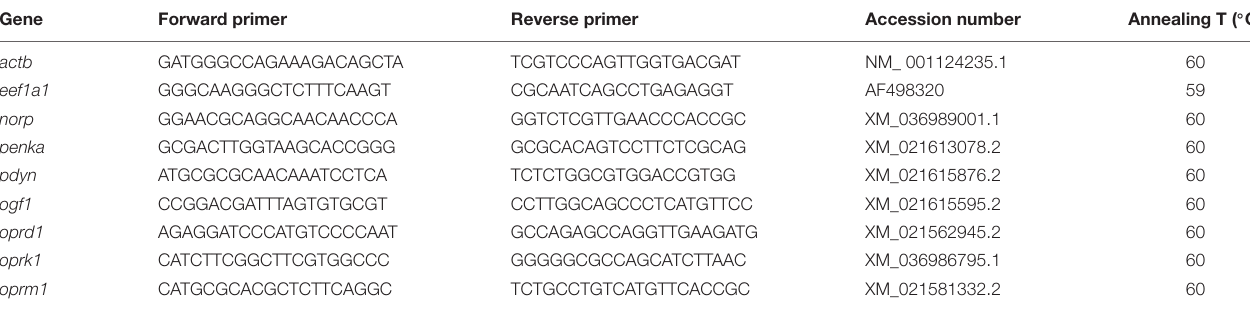
TABLE 1 | Nucleotide sequences of the PCR primers used to evaluate mRNA abundance by RT-qPCR. Gene Forward primer Reverse primer